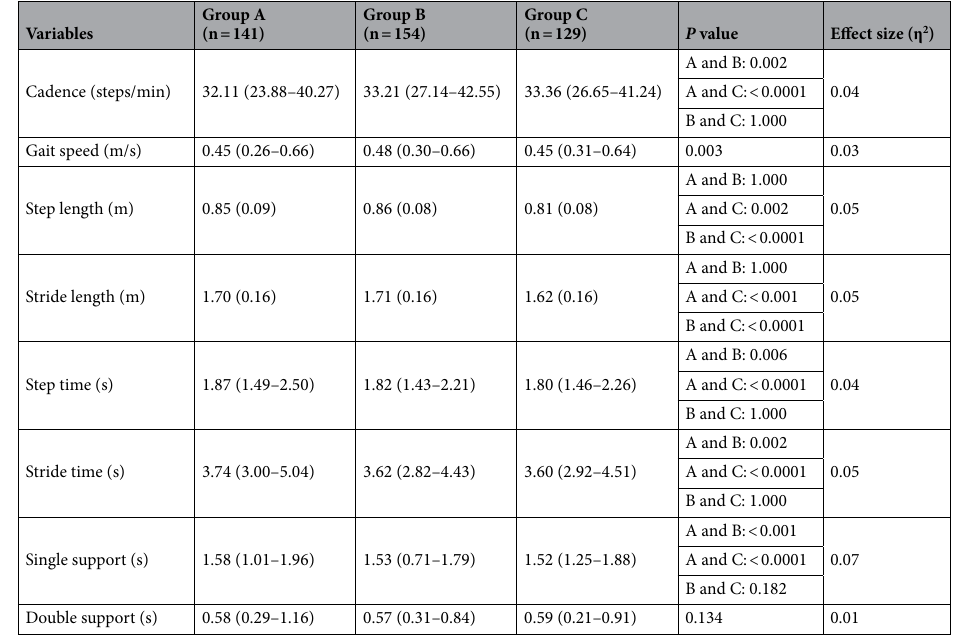
Table 3. Normalized spatiotemporal parameters for each age group (N = 424). Group A (6–8 years), Group B (9–10 years), Group C (11–12 years). Differences between the three groups were analyzed using the Kruskal– Wallis test or one-way analysis of variance. Variables with significant differences were subsequently compared using multiple comparison analyses with Bonferroni correction. Data are presented as means (standard deviation) or median values (range). P values < 0.0001 were considered statistically significant.